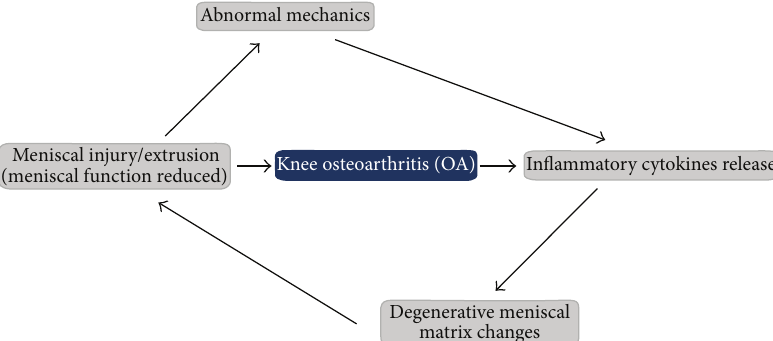
Figure 4: The interaction between meniscal injury and knee osteoarthritis (OA). Knee mechanics become abnormal when a meniscus is injured, which leads to increasing stress across adjacent cartilage and subchondral bone. This stress triggers release of inflammatory cytokines, which further impair the meniscal extracellular matrix (ECM) and accelerate the vicious cycle of knee OA. OA of the knee joint also causes release of inflammatory cytokines, repeating the vicious cycle.